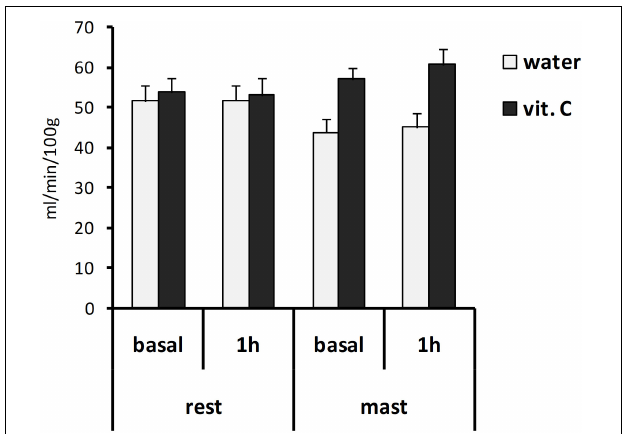
FIGURE 2 | Global brain perfusion values. Bars represent the mean values obtained from the first (basal) or second (1 h) ASL-MRI scan, after a vit. C supplemented (vit. C) or control (water) lunch; the second scan was acquired after resting (rest) or masticating (mast) for 1 h. There was a significant effect for the water/vit. C factor ( p <